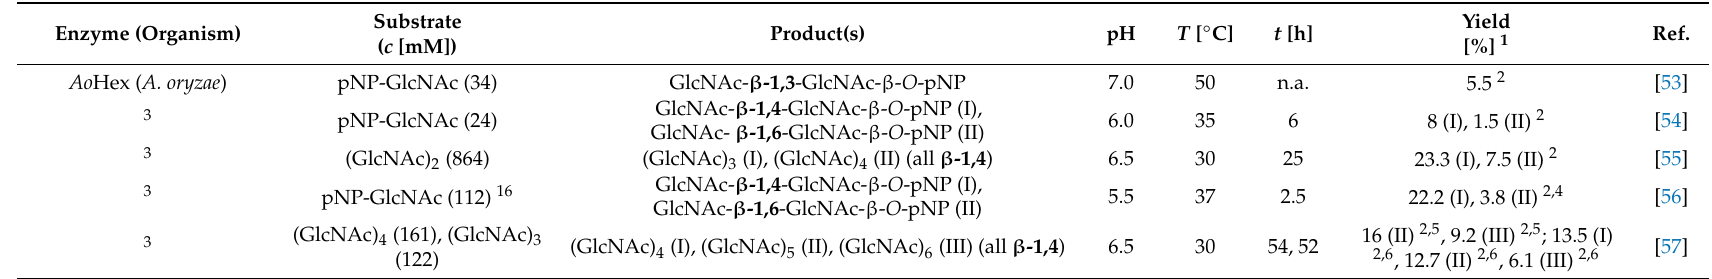
Table 2. Auto-condensation reactions of carbohydrate substrates catalyzed by GH20 β - N -acetylhexosaminidases. New bonds are highlighted in bold. Enzyme